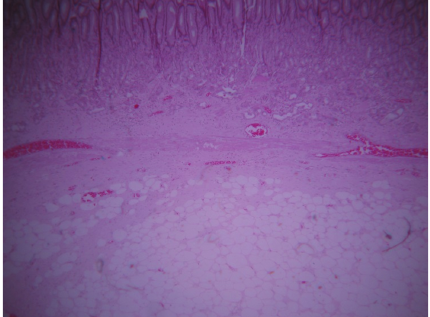
Figure 2: Photomicrograph showing gastric mucosa with submu- cosal adipocytes, confirming